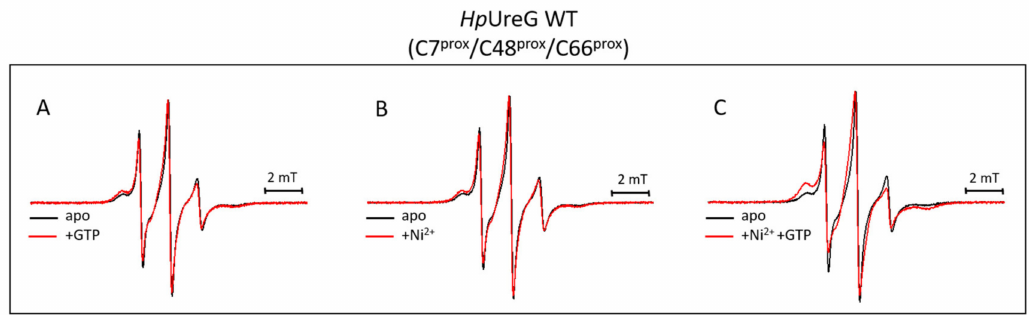
Figure 5. X-band CW EPR spectra of 50 µ M Hp UreG labeled at the three naturally occurring Cys residues, recorded in solution and at room temperature. The apo-form spectra (black line) are compared to spectra recorded in presence of either 3 mM GTP and / or 2.5 mM Ni(II) (red line).